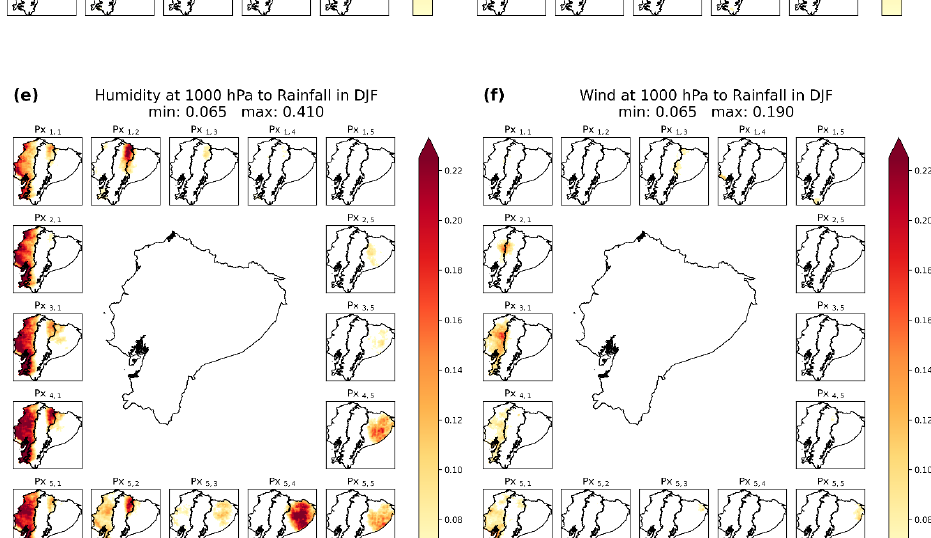
Figure 6. Spatial patterns of GC strength of connections ( p -value ≤ 0.01) between humidity and rainfall in DJF at ( a ) 600 hPa, ( c ) 850 hPa, and ( e ) 1000 hPa; and between wind and rainfall in DJF at ( b ) 600 hPa, ( d ) 850 hPa, and ( f ) 1000 hPa.